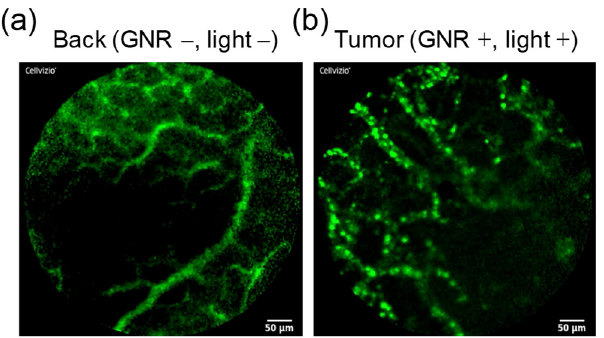
Figure 6. Distribution of fluorescence-labeled polyoxazoline (POZ) in the untreated normal tissue (back) ( a ) and in the tumor treated with gold nanorods (GNRs) and near-infrared (NIR) irradiation ( b ), which was visualized using confocal microscopy. Green: FITC-labeled POZ. Scale bar = 50 μ m.